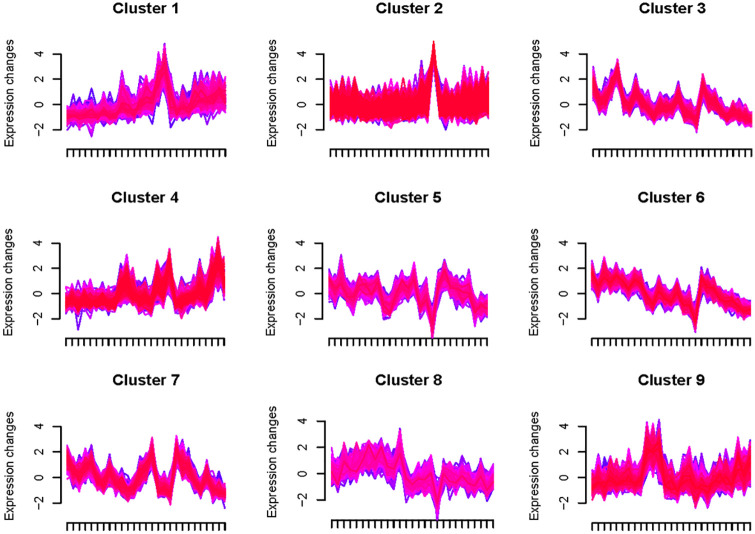
Nine gene clusters were discovered among different samples.Many genes could be classed into one cluster according to their similar expression patterns at different time points. X-axis represents different time points. Y-axis represents the expression value after homogenization.